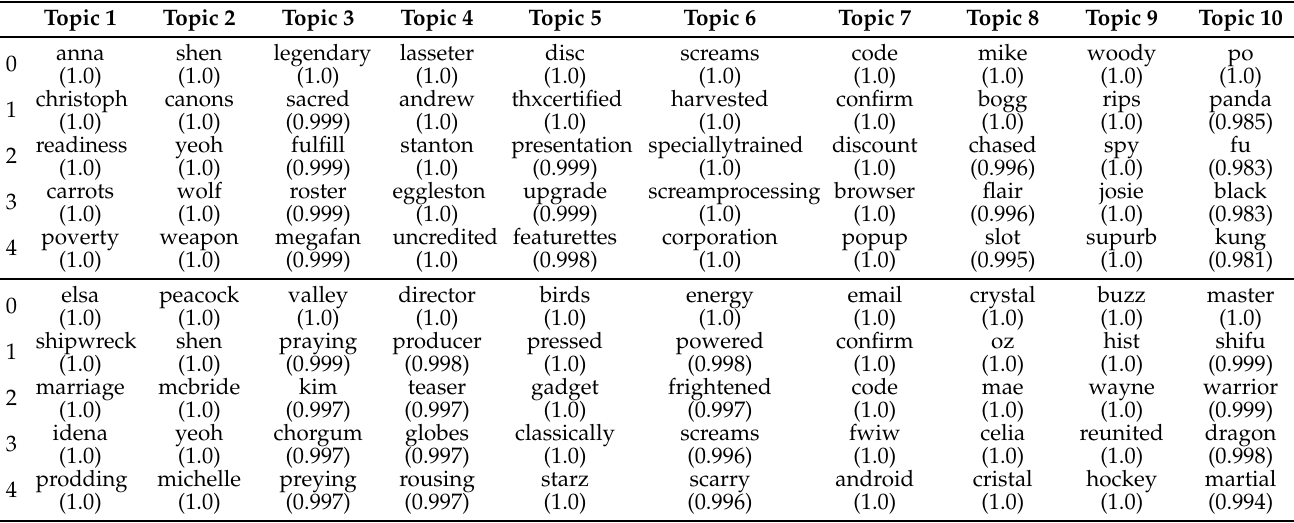
Table A16. For the most significant two words per topic, the four nearest neighbors based on cosine similarity are listed. Topic 1